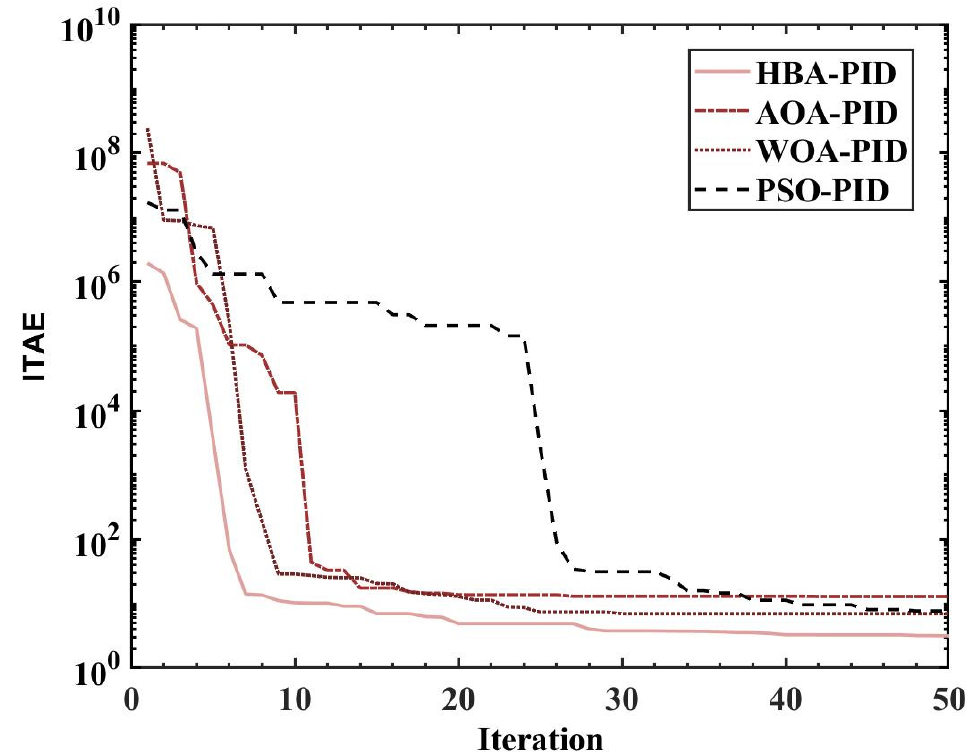
Figure 13. Fitness curves when optimal parameters are obtained by four metaheuristic algorithms. The overshoots obtained by the HBA-PID algorithm, AOA-PID algorithm, WOA-PID algorithm, and PSO-PID algorithm with a population size of 50 are 0.168%, 7.9185%, 14.6905%, and 25.3665%, respectively, while the rise times are kept short. It can be seen that using ITAE as the fitness, the rise time is preferred between the balance of overshoot and rise time. Since the amount of overshoot has a large impact on the attitude control of the balancing robot, the CF-ITAE indicator is proposed to achieve the fusion between ITAE and overshoot by using the CF. CF-ITAE enables the metaheuristic algorithm to ob- tain parameters that balance overshoot and rise time in the search for the optimal param- eters. To verify the effectiveness of CF-ITAE, we compare the PID parameters and the time-domain metrics of the attitude control of the balancing robot obtained by combining HBA-PID, AOA-PID, WOA-PID, and PSO-PID algorithms with CF-ITAE. The CF is 0.05, the number of populations is 50, and other parameters are set as before. The data are shown in Table 7, and the step response of the actual angle of the balancing robot is shown in Figure 14. In order to test the robustness of the algorithm when subjected to external disturbance, we apply an external force to break the balance of the balancing robot at a population size of 50, when time t = 1, and compare the robustness of the algorithm by observing the recovery speed and the magnitude of overshoot of the balancing robot. The actual angle of the balancing robot under CFHBA-PID, CFAOA-PID, CFWOA-PID, and CFPSO-PID algorithms after applying the external force is shown in Figure 15, and the corresponding fitness curve is shown in Figure 16.